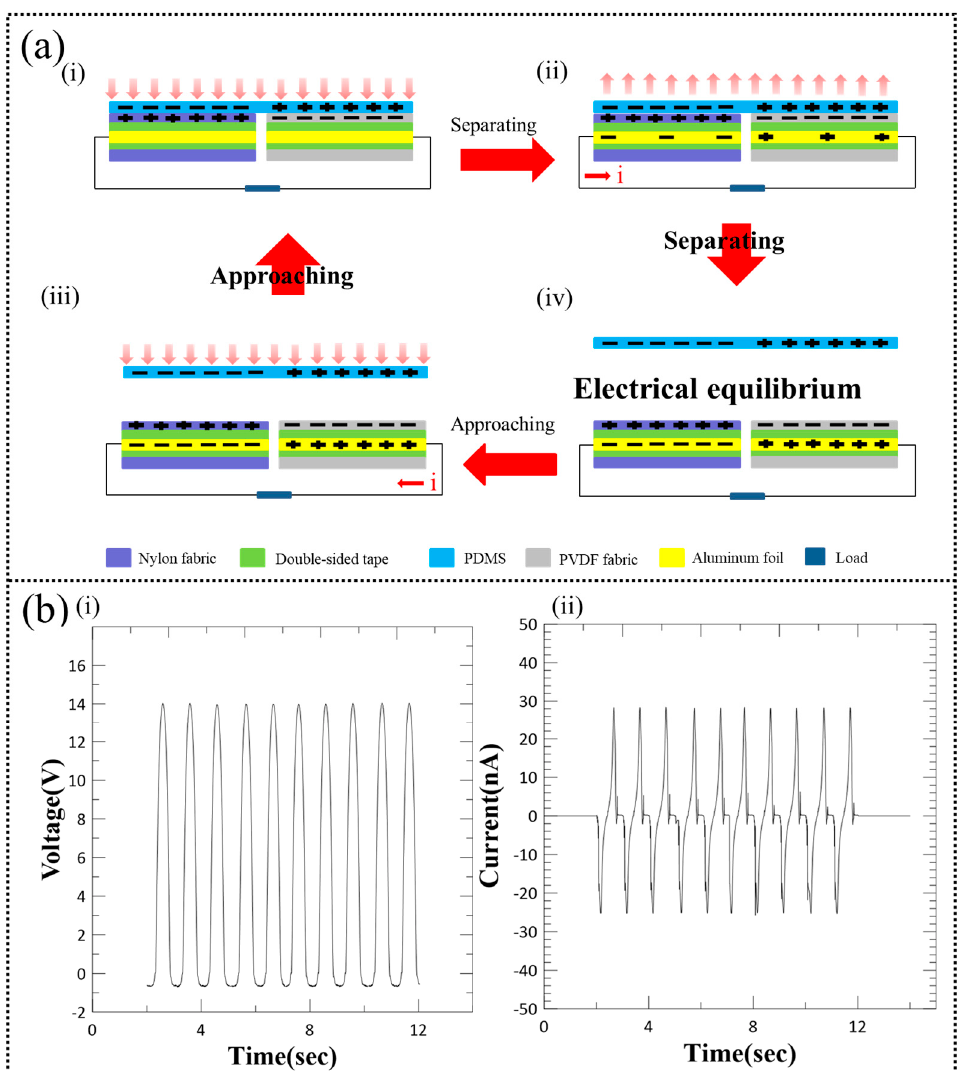
Figure 5. ( a ) Schematic of structure and working mechanism of freestanding TENG (FTENG) under vertical contact mode as the freestanding PDMS layer approaches contacts and separates from the FTENG. ( b ) Electrical performance of the FTENG: (i) Voltage output and (ii) current output.